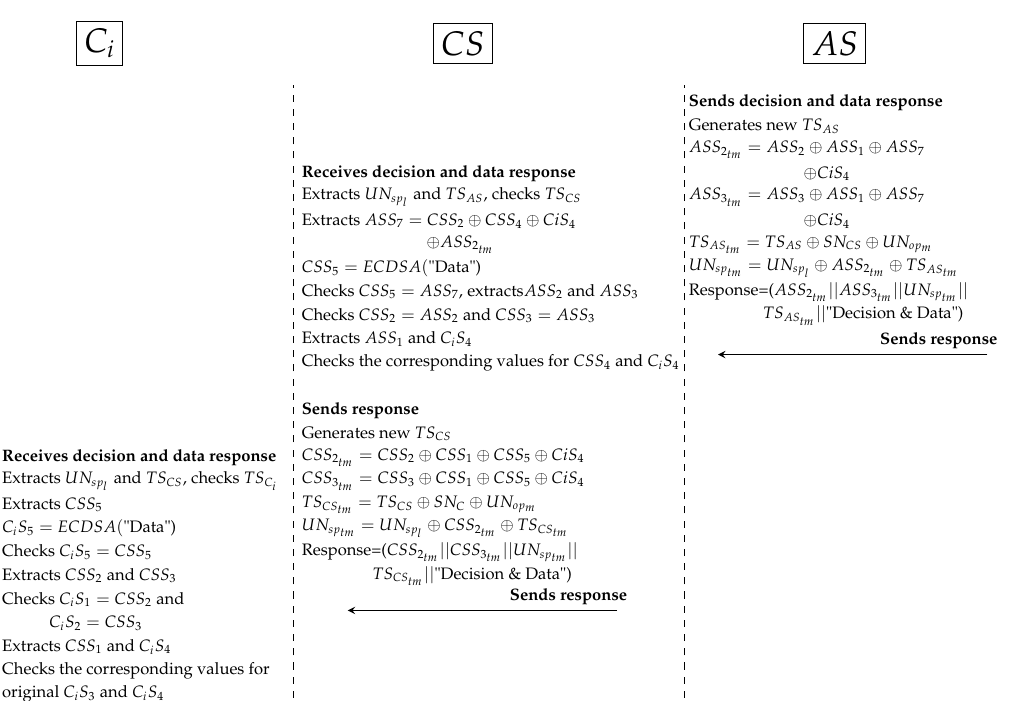
Figure 12. Protocol of PAX model between AS , CS and C i